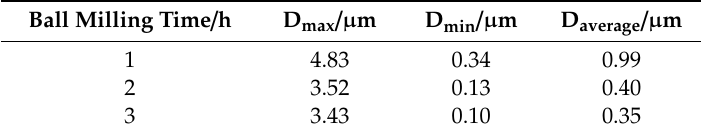
Table 2. Statistical results of particle size.